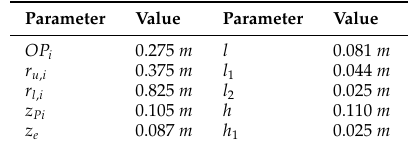
Table 1. Geometrical parameters of the parallel robot.